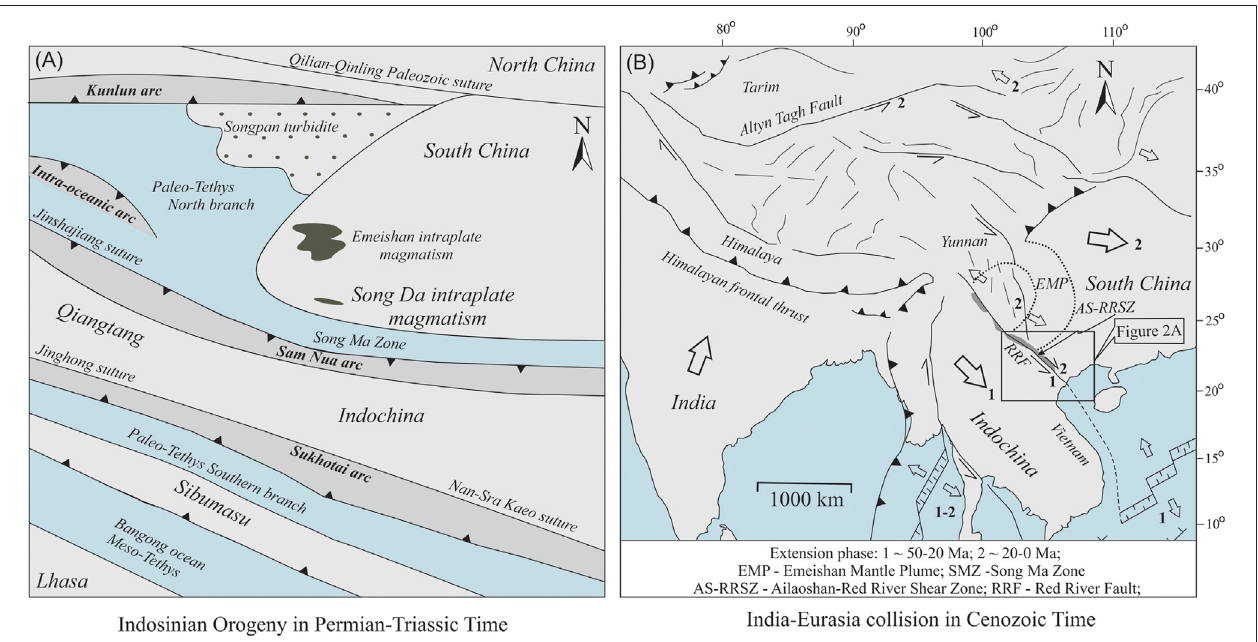
FIGURE 1 | Geographic reconstructions of two main events controlled tectonic deformations of northern Vietnam. (A) A series of Tethyan sutures relate to Gondwanaland dispersion and Asian accretion in Permian-Triassic time (Modi fi ed from Faure et al., 2014). In northern Vietnam, Triassic-Permian event relates to the closure of Paleo-Tethys and subsequent collision of Indochina and South China blocks as de fi ned as Indosinian Orogeny. The evidence of that event was recognized in Song Ma suture and Sam Nua arc. (B) Cenozoic tectonic deformation of Southeast Asia (Modi fi ed from Tapponnier et al., 1982). Solid lines represent major faults. Black arrows indicate direction of strike-slip faults. Large colorless arrows present relative movement of blocks respect to Central Asia. Small colorless arrows indicate directionofextrusion-relatedextension.Barbedlinesarethrustfault.Numberreferstoextension phase: 1 – 50 – 20 Ma; 2 – 20 – 0 Ma. EMPisEmeishan Mantle Plume,AS- RRSZ is Ailao Shan-Red River Shear Zone; RRF is Red River